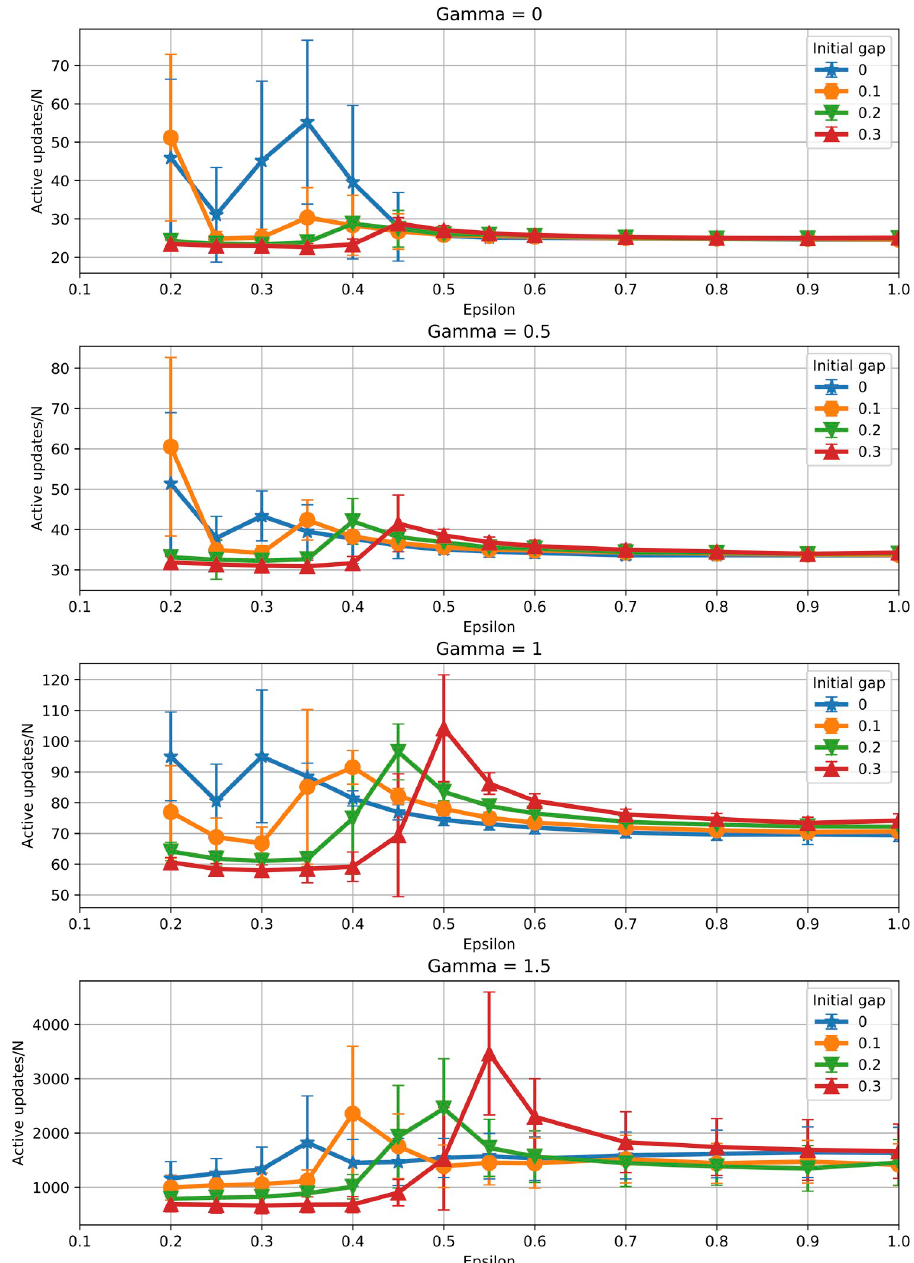
Fig 11. Initial condition: Time to convergence. Effect of the initial condition on the convergence time measured in number of active interactions (averages over 100 runs).